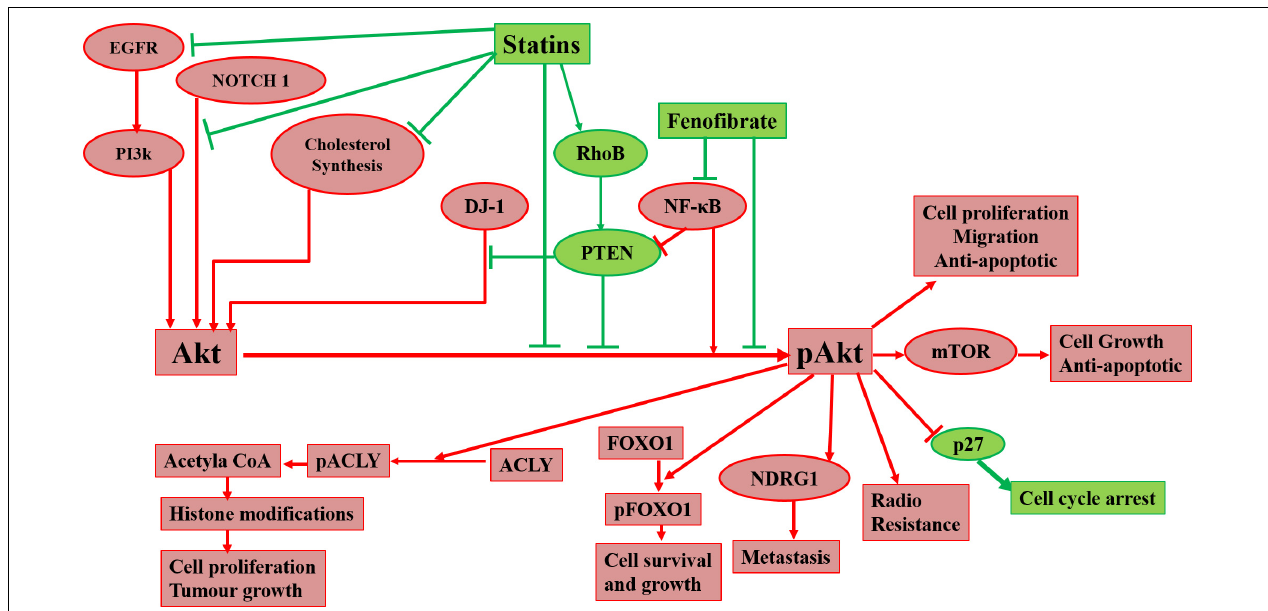
FIGURE 1 | Diagrammatic representation of effects of cholesterol-lowering drugs on Akt in cancer signaling. Statins can act on Akt via inhibition of cholesterol synthesis, EGFR, NOTCH 1, and the promotion of RhoB. Fenofibrate can also act on Akt via inhibition of NF- κ B. Inhibition of Akt phosphorylation leads to prevention of radioresistance, cell proliferation, migration, and metastasis of cancer cells and promotion of apoptosis and cell cycle